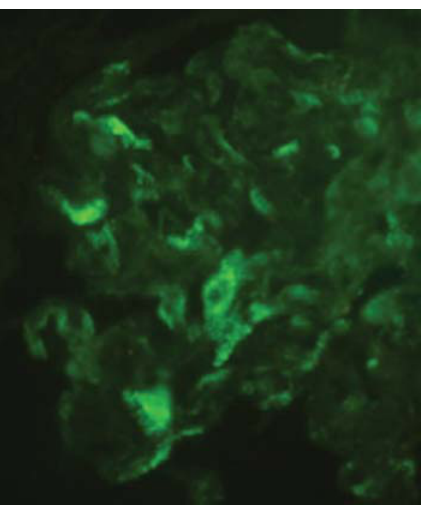
Figure 1 - Renal biopsy with mesangial IgA deposition (inmunofluores- cence,